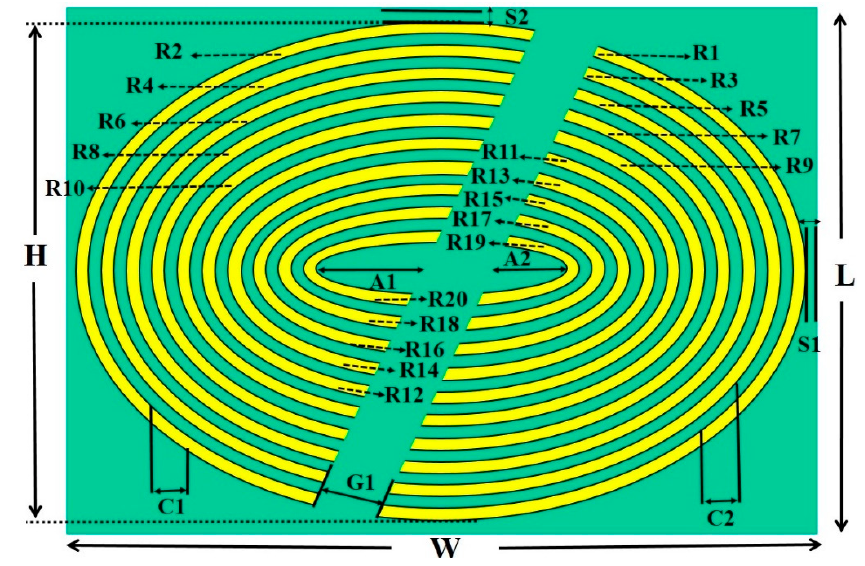
Figure 6. Proposed multi-resonator chipless tag layout.